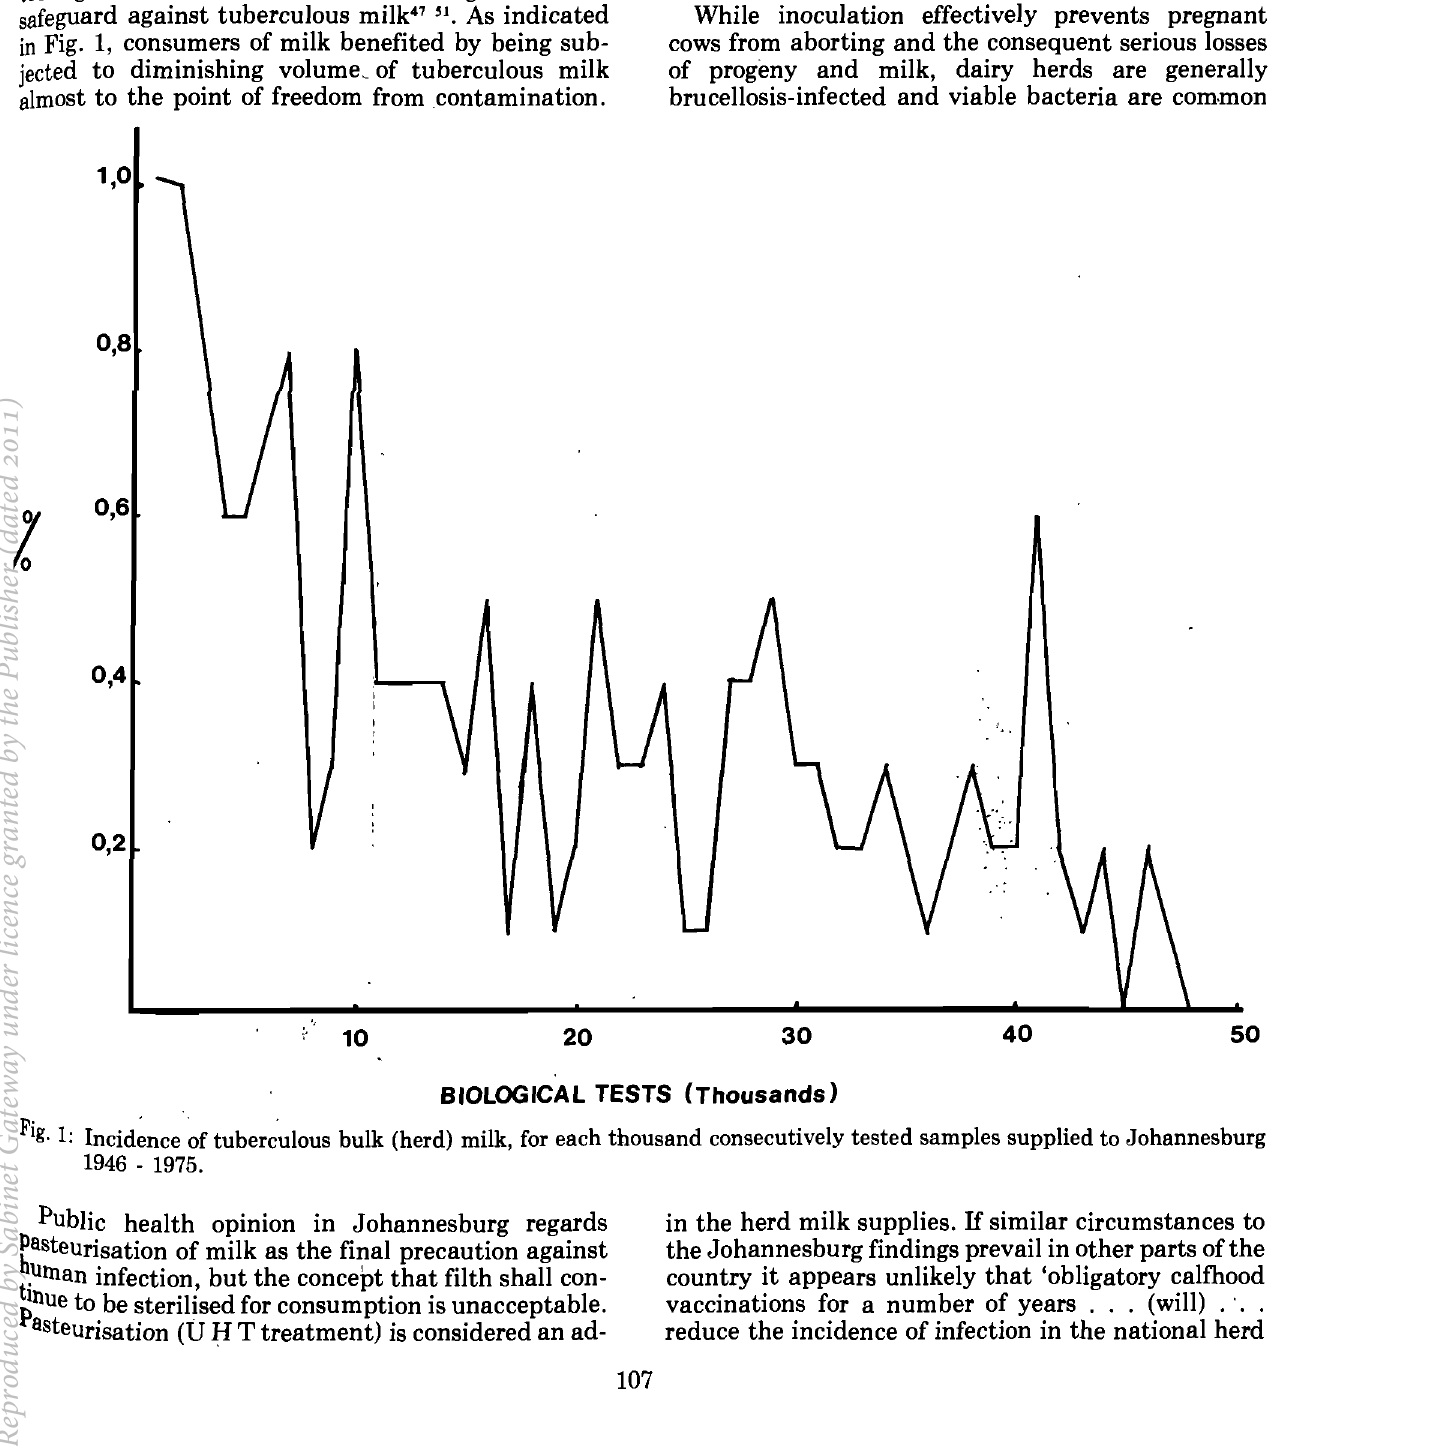
Fig. 1: Incid~nce of tuber~ulous bulk (herd) milk, for each thousand consecutively tested samples supplied to Johannesburg 1946 -